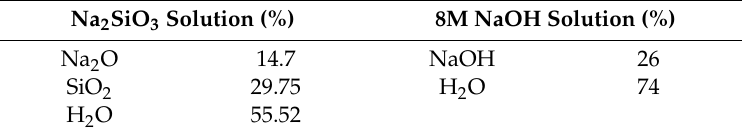
Table 3. The chemical composition of the alkaline solution (% by mass).